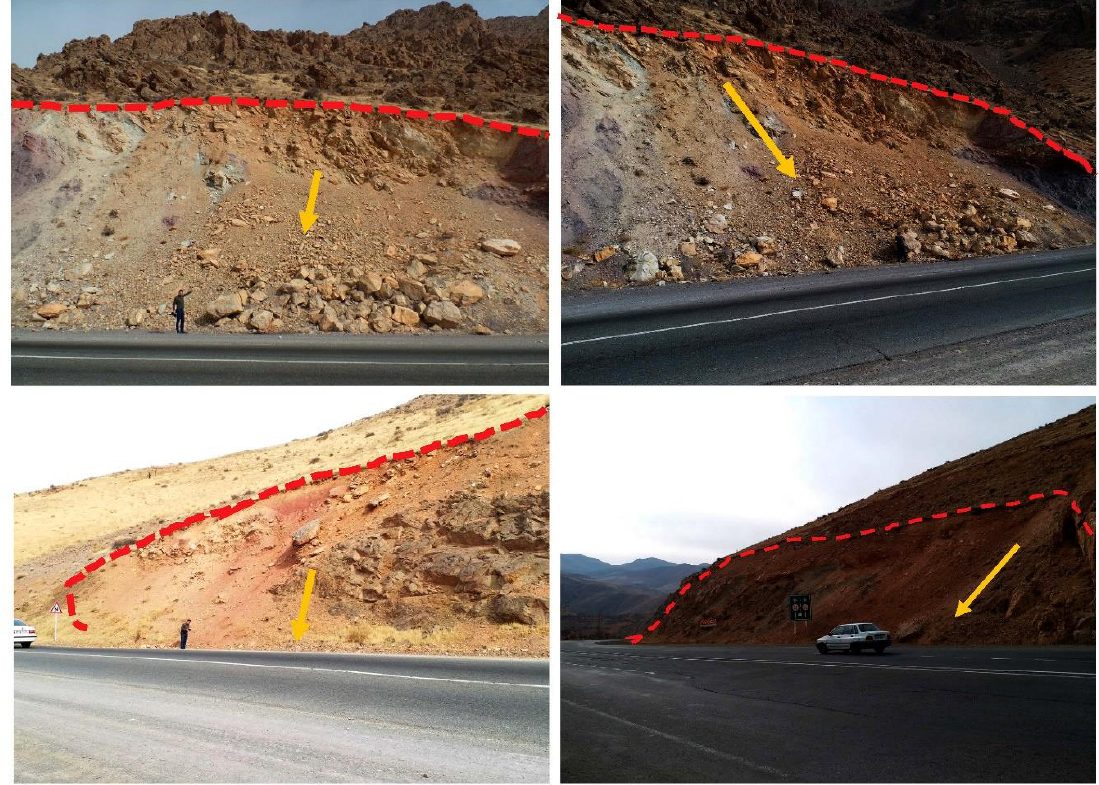
Figure 2. Examples of shallow landslides in the study area.